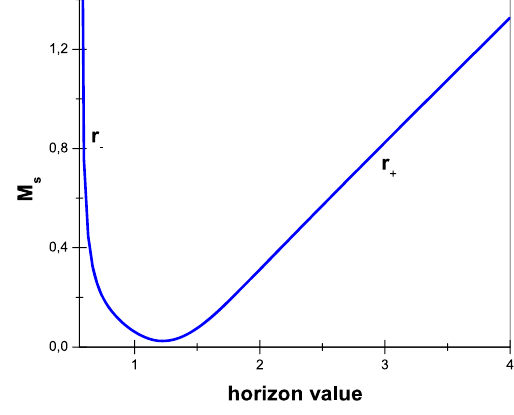
Fig. 1 Behavior of M s parameter for α = Q = R = 1, M q = 0 . 7 black hole. It is worth to mention that the combination of both energy density models, (55) and (57), provides a new model of regular black holes, inserting Eqs. (56) and (58) into Eq.